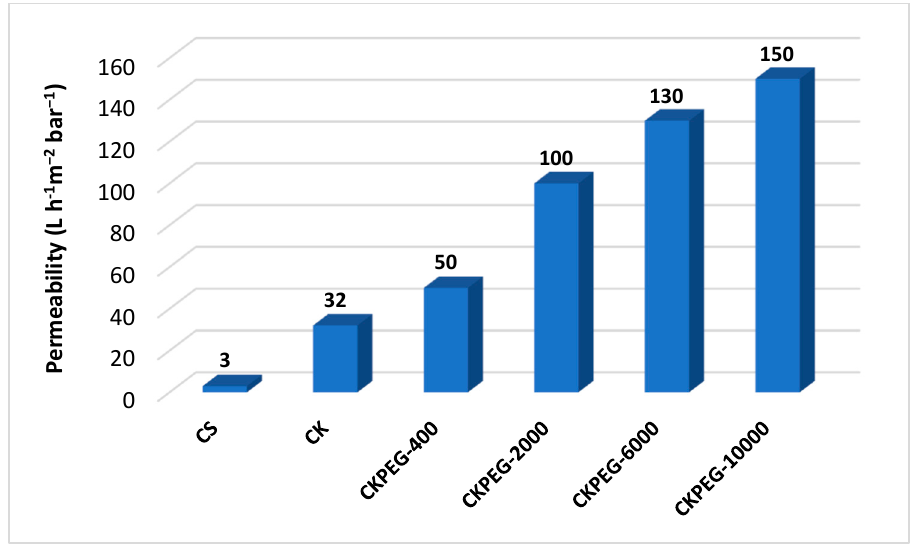
Figure 11. Pure water permeability values of the prepared membranes.